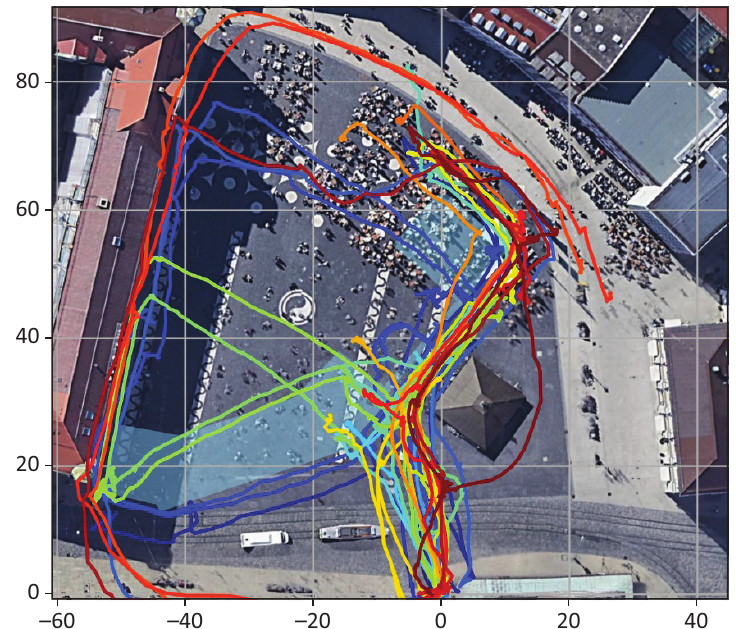
Figure 4. Walking lines in augmented